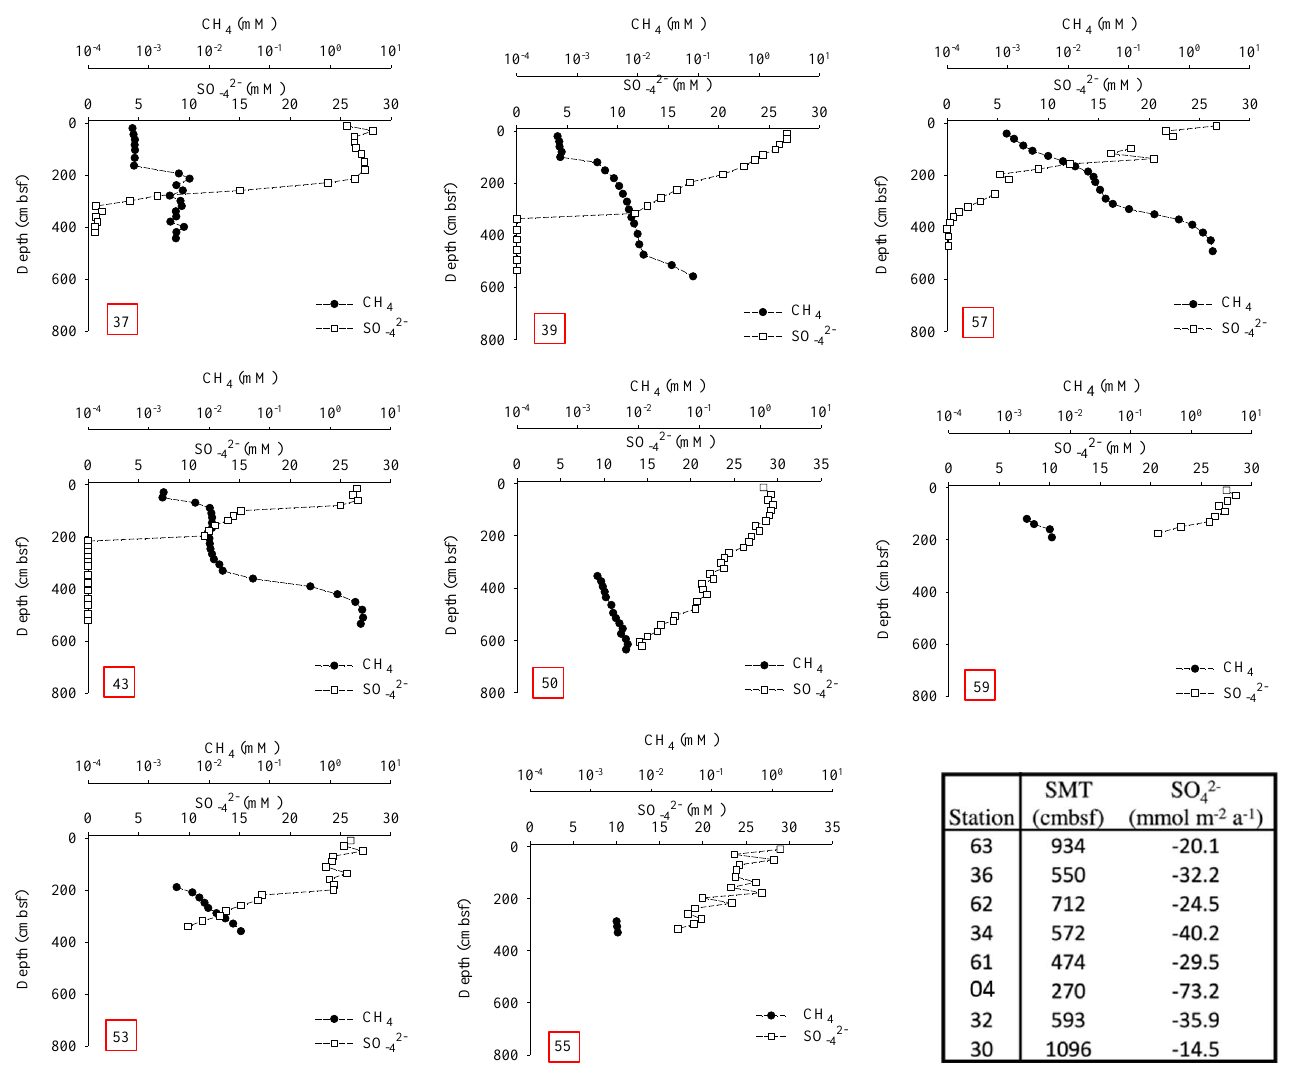
Figure 7. Geochemical data from Mahia Transect 2. Piston core numbers presented in seismic profile (Figure 6) are indicated in red boxes. See Figure 1b for geographical locations and Figure 6 for locations on TOPAS and seismic data. Geochemical data include sediment CH 4 and porewater SO 42 − concentrations. “cmbsf” = cm below seafloor. Table in lower right shows the sulfate–methane transition zone (SMT), determined from the SO 42 − concentrations.